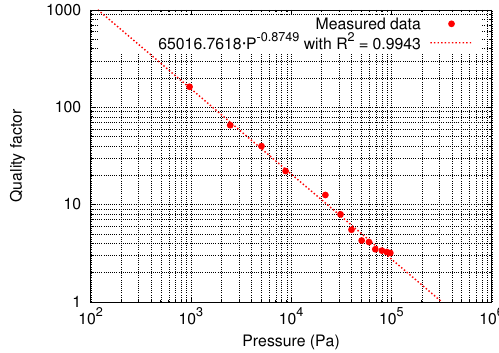
Figure 14. Measured quality factor variation as a function of pressure.